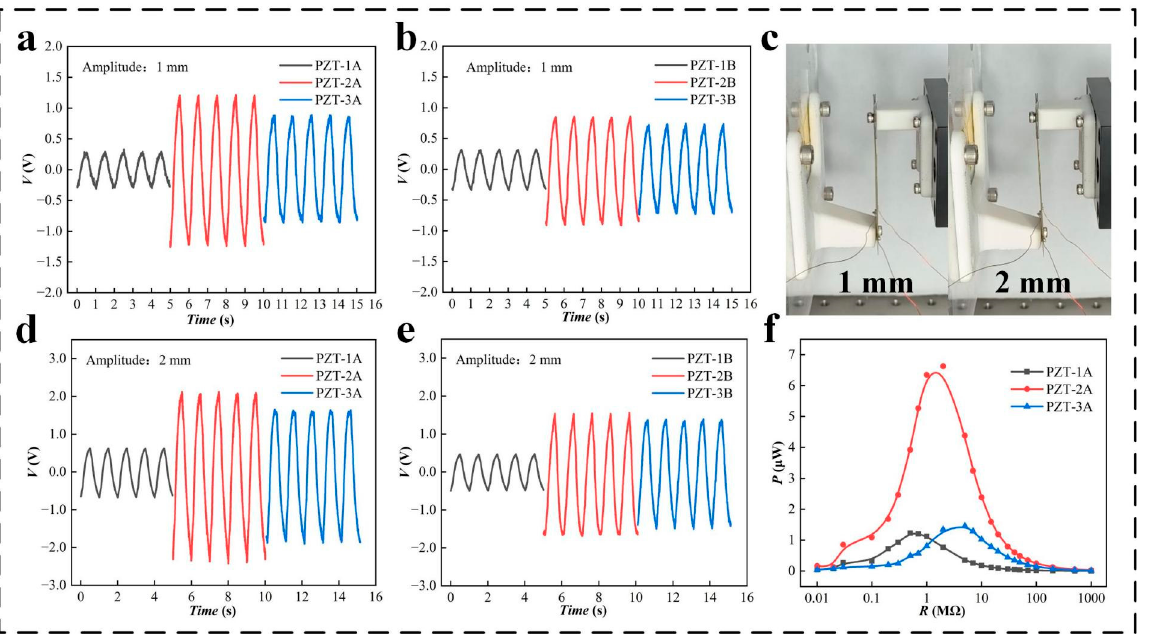
Figure 3. The output performance of the PZT units having different specifications: ( a , b ) voltage ( V ) of the PZT units having different specifications for a stroke of the motor of 1 mm, ( c ) photograph of motor strokes of 1 and 2 mm, ( d , e ) V of the PZT units having different specifications for a stroke of the motor of 2 mm, ( f ) power of the different PZT units for a stroke of the motor of 2 mm.